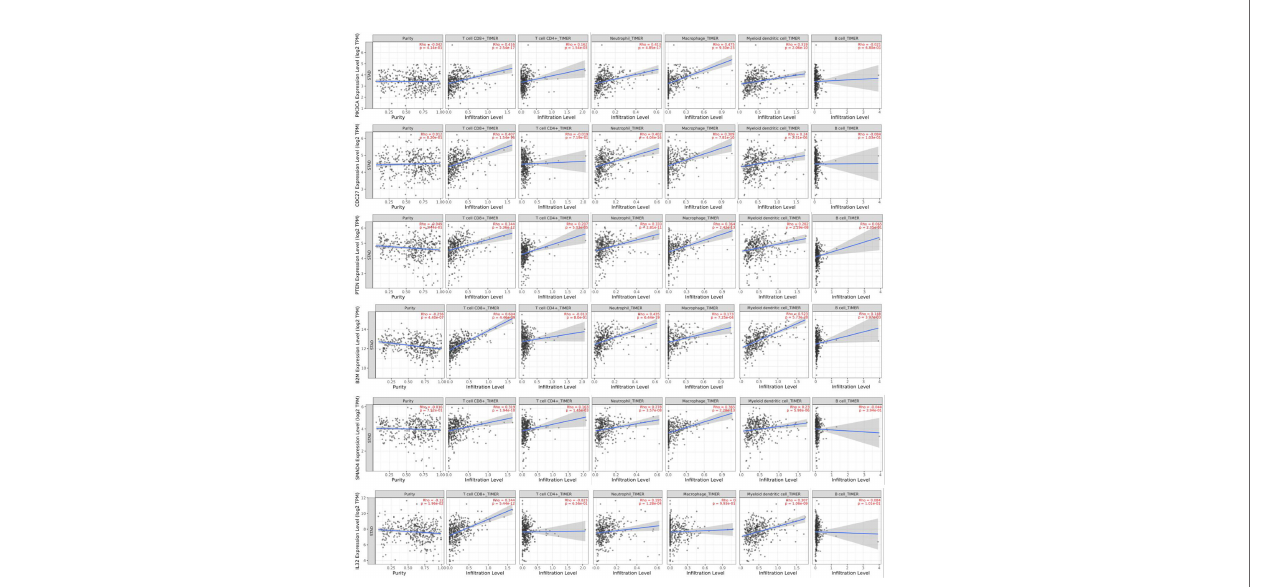
FIGURE 7 | Correlation of six genes expression with immune in fi ltration level in GC.